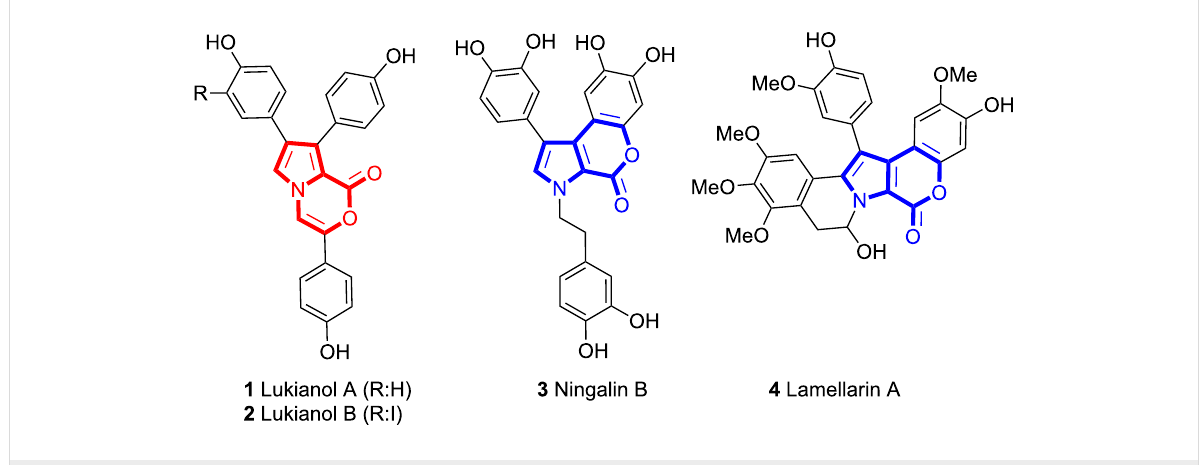
Figure 1: Structures of some marine natural products 1–4 .